Question: Reading the figure, is the described quantity rising or falling?
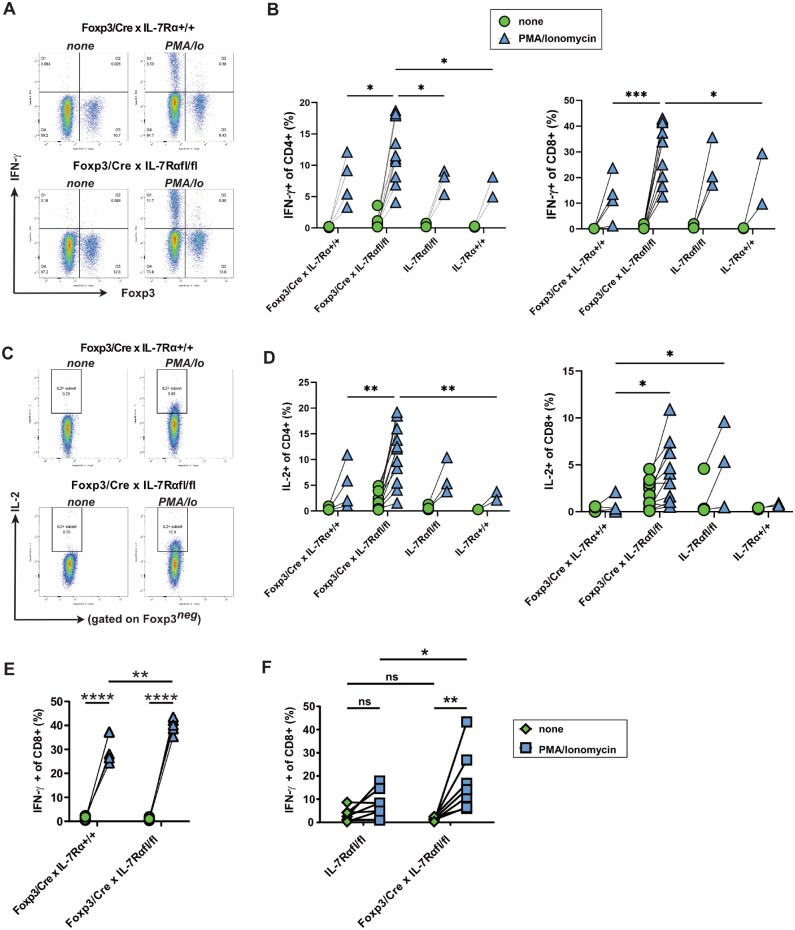
Answer: increasing